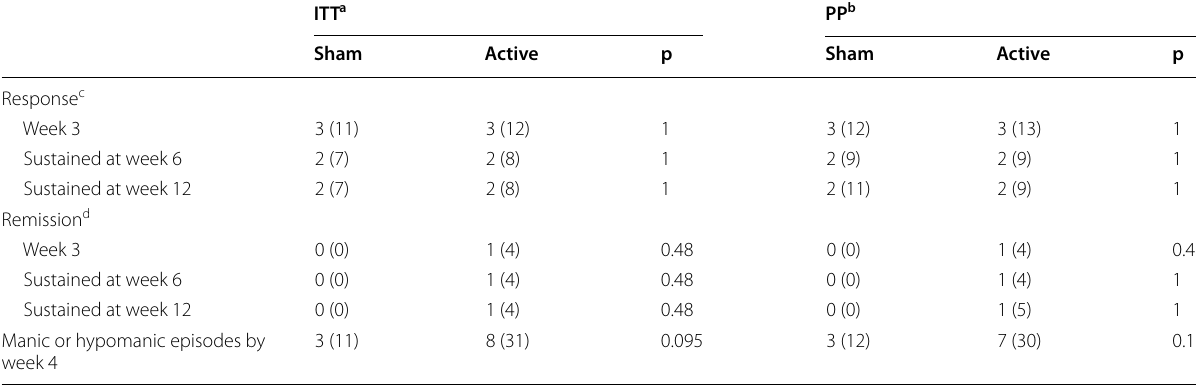
a Sham n 28, treatment n = b Sham n at week 3, 6 and